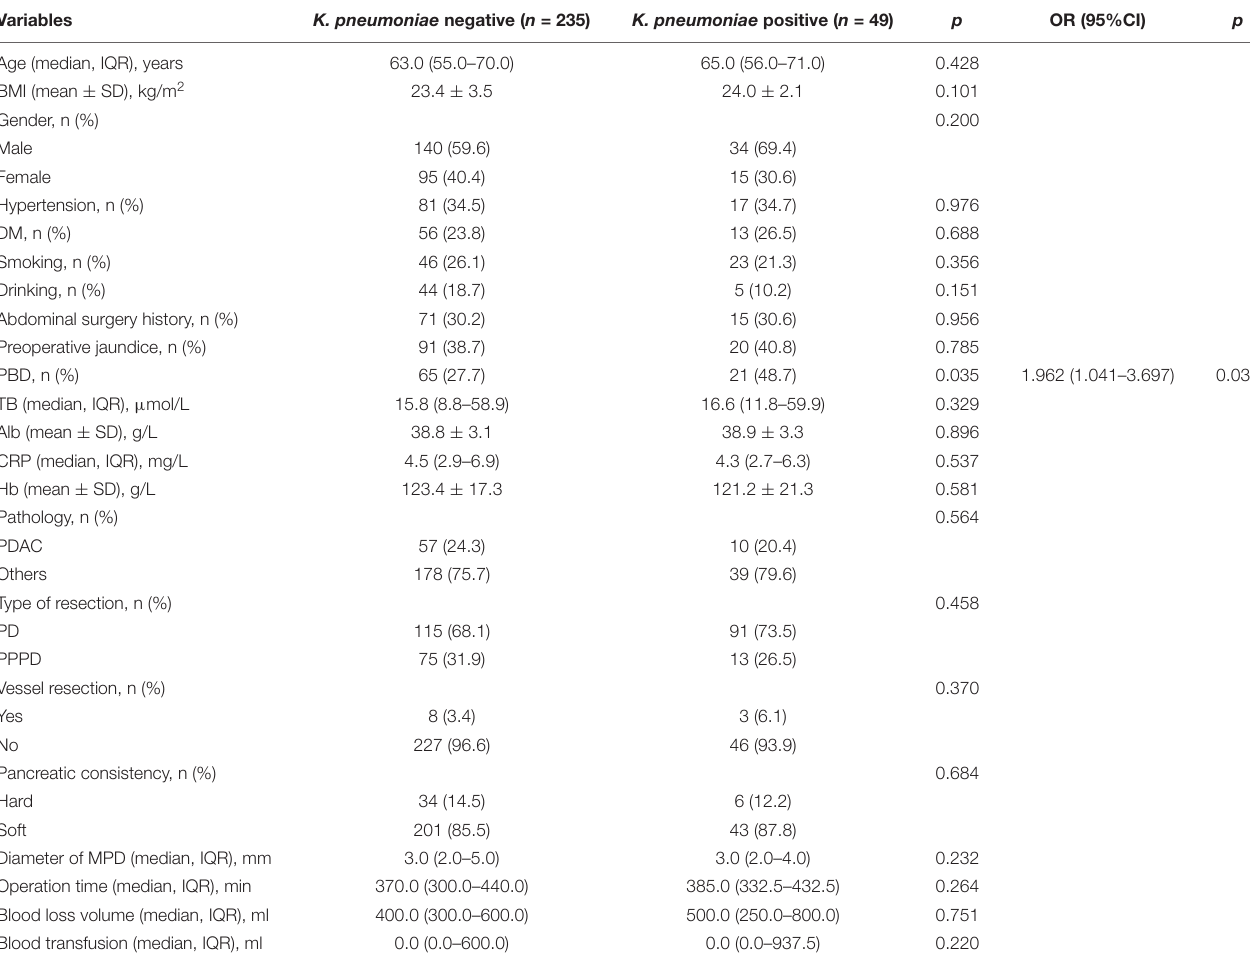
TABLE 4 | Univariate and multivariate analysis of the contamination of K. pneumoniae of drain fluid after PD.